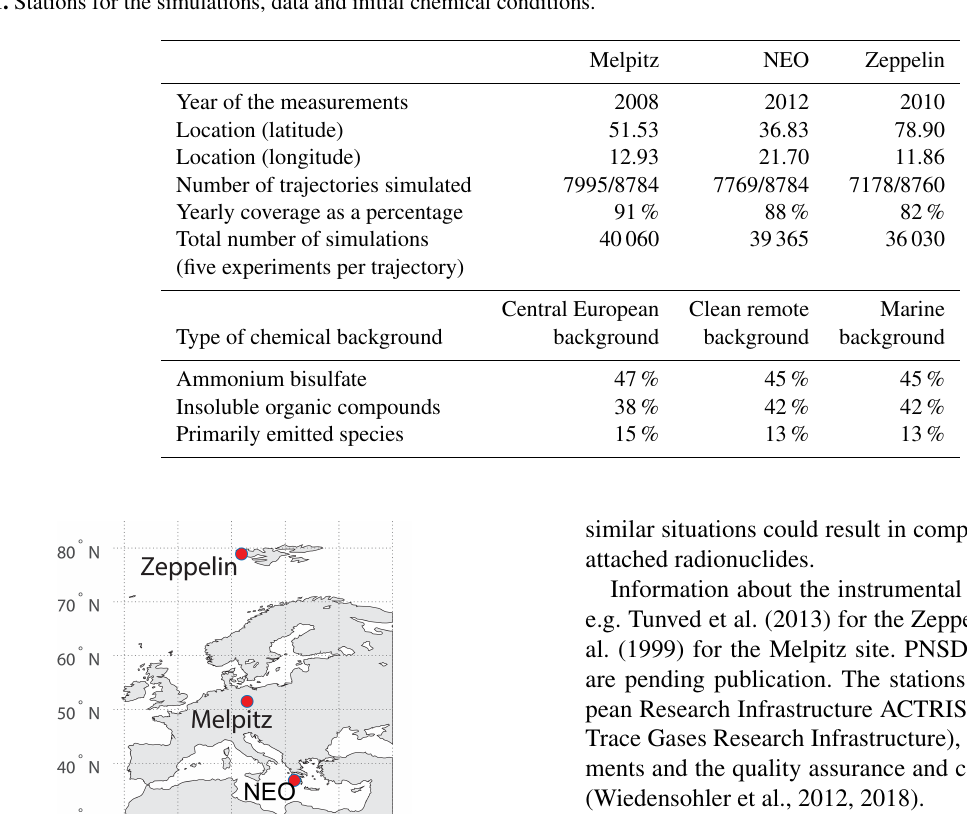
Table 1. Stations for the simulations, data and initial chemical conditions.